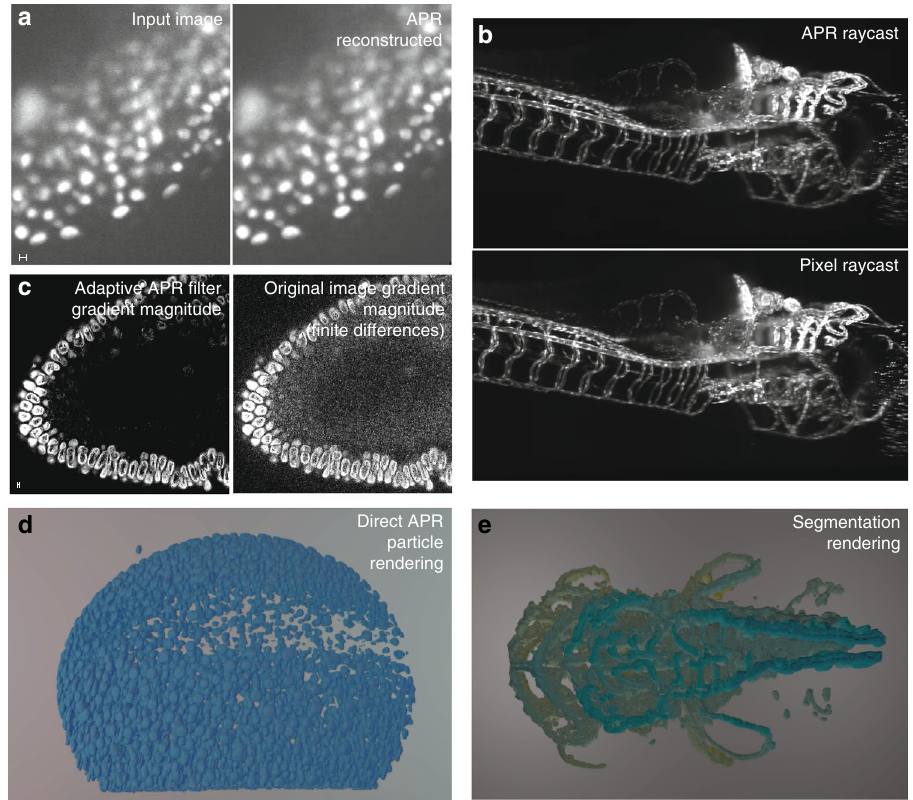
Fig. 4 Image processing using the APR. a Comparison of an example image (exemplar dataset 7 25 ) with its piecewise constant APR reconstruction. b Comparison of the maximum-intensity projection of a direct 3D APR raycast with the maximum-intensity projection of the pixels for exemplar dataset 17 (full image see Supplementary Fig. 45). c Comparison of the intensity-gradient magnitude estimated using the Adaptive APR Filter and using central fi nite differences over the pixels for exemplar dataset 6 (Tomancak Lab, MPI-CBG). d Direct 3D particle rendering of zebra fi sh nuclei (exemplar dataset 7 37 ) using Scenery. (Raw images in a , b , d , e courtesy of Huisken Lab, MPI-CBG & Morgridge Institute for Research.) Scale bars indicate 10 pixels. Additional details can be found in Supplementary Note 22. e APR volume rendering of a 3D image-segmentation result, colored by depth using the open-source visualization tool Scenery 36 , computed using graph-cut segmentation directly on the APR, as described in Supplementary Note 22 (exemplar dataset 13 37 ). Segmentation on the APR took 5.5 s. Segmentation on the pixel image was impossible on our benchmark machine due to memory over fl